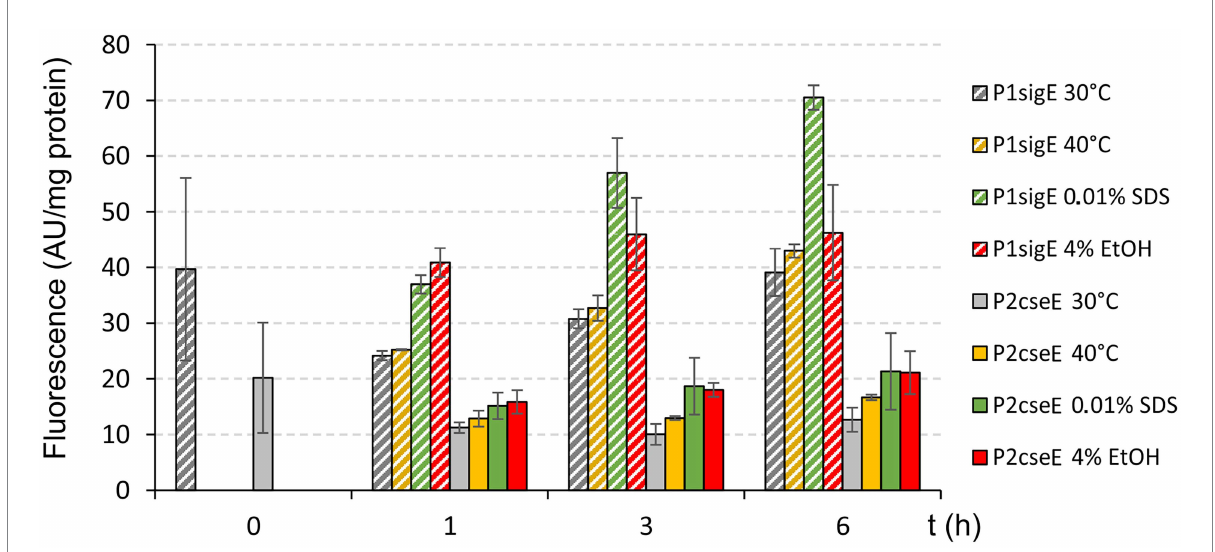
FIGURE 3 Effects of stresses on activity of P1 sigE and P2 cseE . The C. glutamicum cells carried the promoter-test vector pEPR1 with the promoter P1 sigE or P2 cseE . Promoter activity was measured as the GFPuv fluorescence intensity of cell extracts and is shown as bars representing the respective growth/stress conditions. Error bars depict the standard deviations of three biological